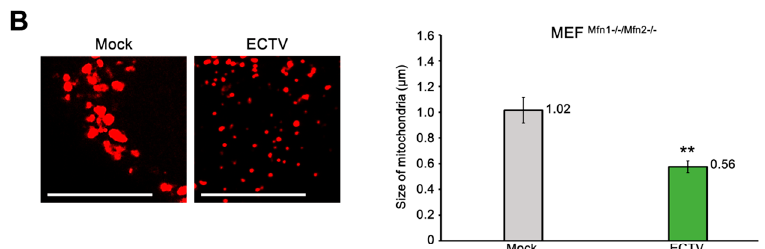
Figure 8. Hyperfragmentation of mitochondria in mouse embryonic fibroblast MEF Mfn1 − / − /Mfn2 − / − cells at 18 hpi with ECTV. ( A ) Arrowheads indicate accumulation of mitochondria around viral factories in MEF WT and MEF Mfn1 − / − /Mfn2 − / − cells. ( B ) The mean size of mitochondria in mock- and ECTV-infected MEF Mfn1 − / − /Mfn2 − / − cells. Data from three independent experiments are presented as mean ± SD ( n = 100 mitochondria/cell, 50 cells were analyzed). Student’s t -test; ** p ≤ 0.01. Scale bar: 10 µ m ( A , B ).